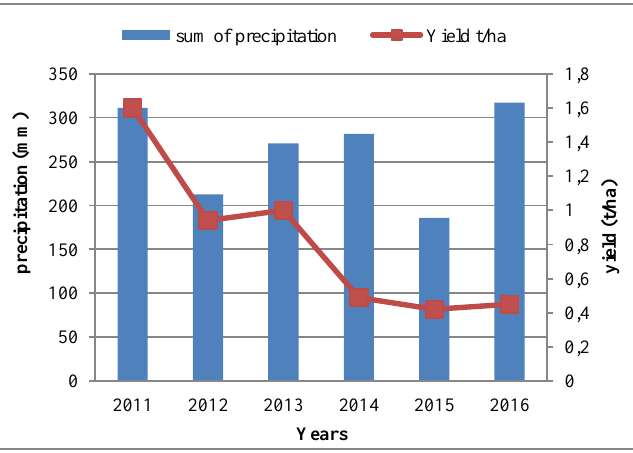
Figure 5. Formation of the lovage seeds productivity depending on the sum of precipitation during the vegetation periods of 2011-2016. The productivity of the lovage seeds during the years 2011- 2016 fluctuated between 0.43 (2015) and 1.6 (2011) t hа -1 , variation coefficient was 55.32, which means that during the years the productivity essentially varied. According to the data of the statistic calculations, the coefficient of variation according to the sum of the active temperatures was low and reached 3.88%, according to the amount of the precipitation – 20.19%, which proves the working hypothesis on the insufficient influence of the limiting factors on seed productivity (coefficient of correlation according to the sum of active temperatures r=0.42, according to the amount of precipitation r=0.30).